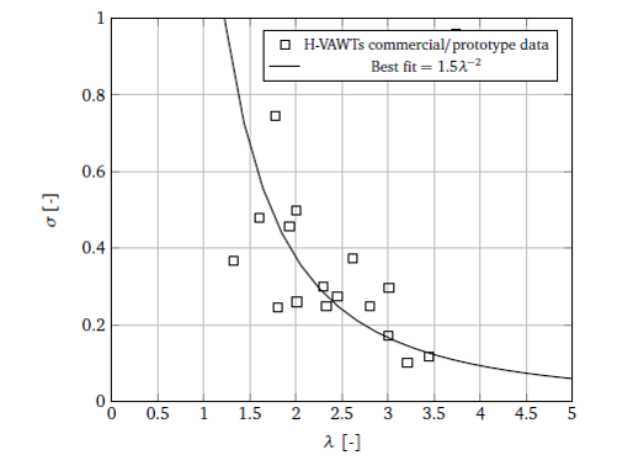
Figure 4. Solidity vs. tip speed ratio for a collection of VAWTs.